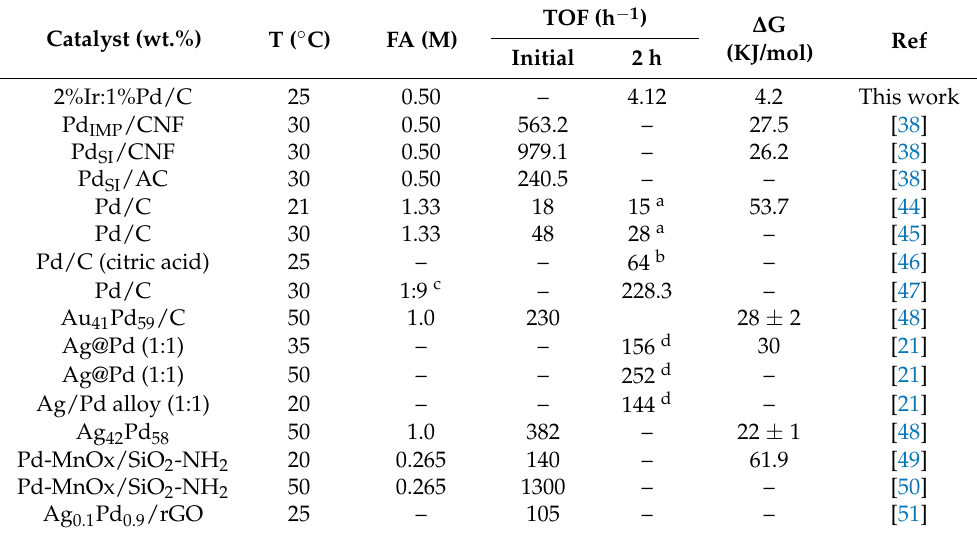
Table 1. Catalytic activities of different types of catalysts for the decomposition of formic acid. Catalyst (wt.%)